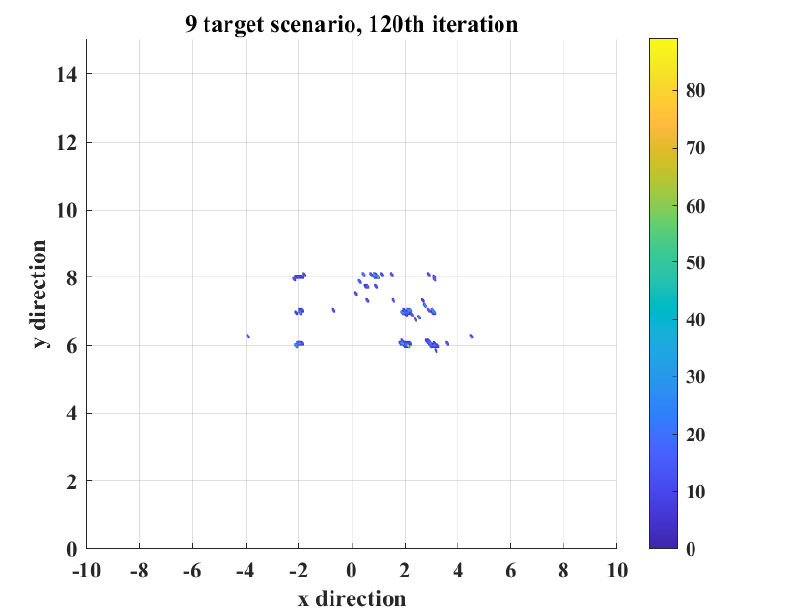
Figure 14. Surviving particles of the proposed algorithm at the end of 120th iteration for the same scenario as in Figure 13. The color scale indicates the mass of the particles.